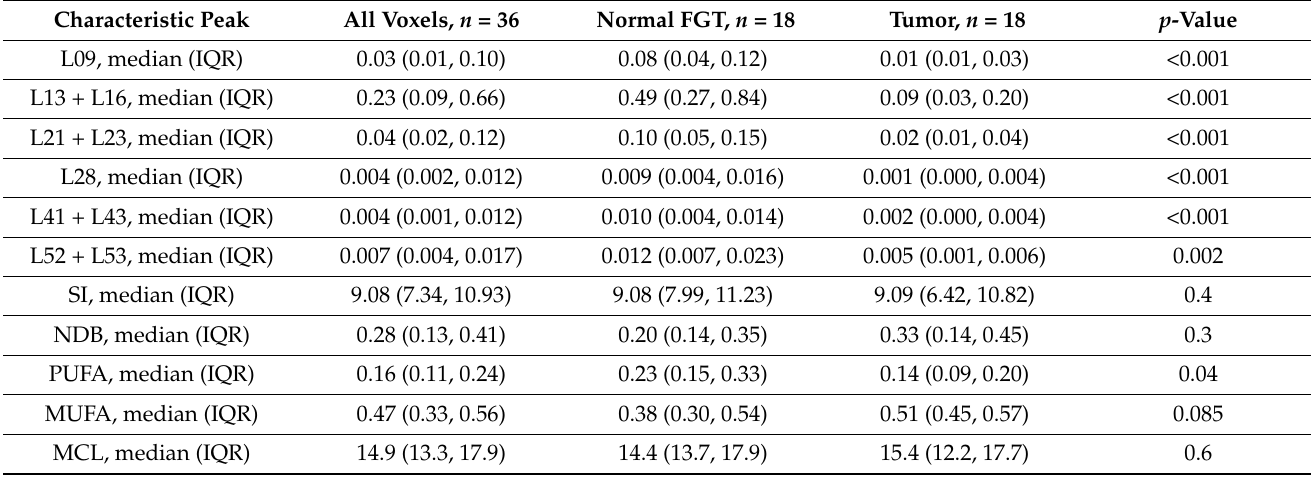
Table 1. Fat peaks (concentrations in millimoles) obtained for all voxels, normal fibroglandular tissue (FGT) and tumors. P ‐ values refer to the comparison of fat peaks between normal FGT and tumors. Characteristic Peak